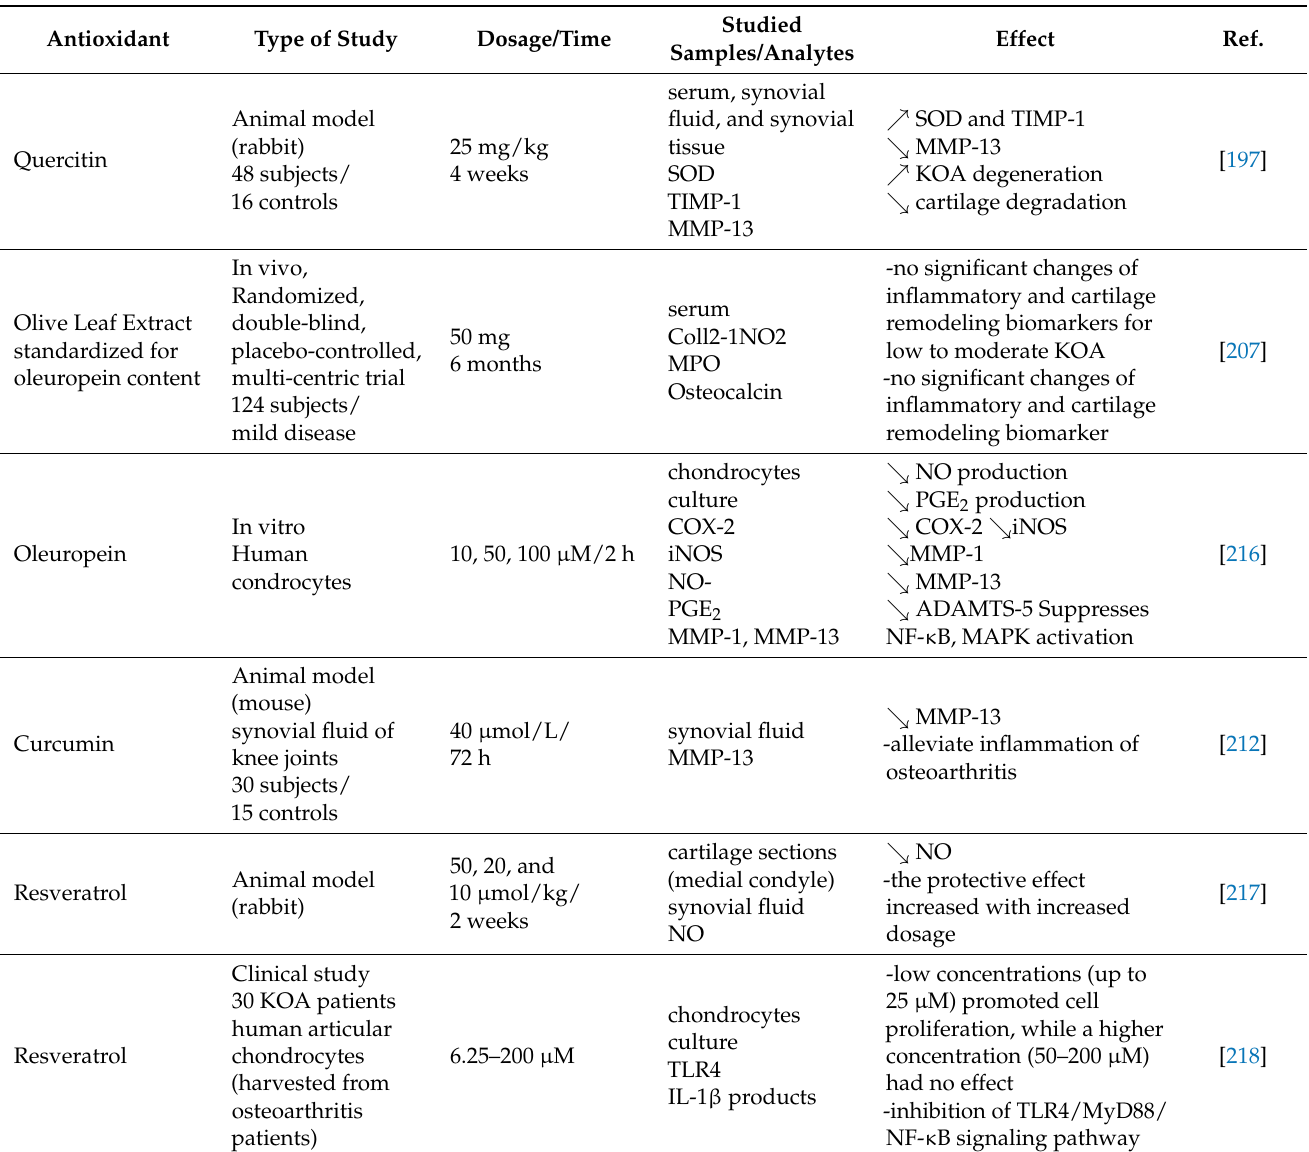
Table 1. Antioxidants and Their Effect on